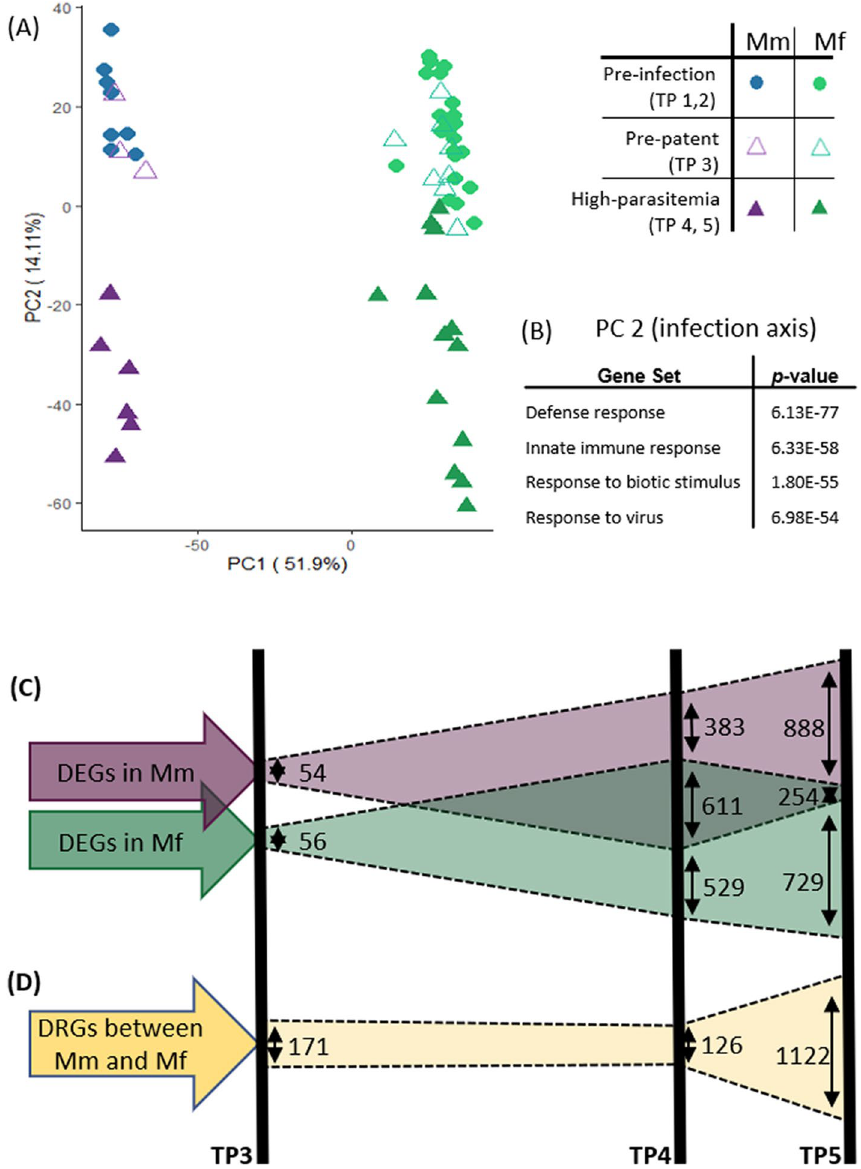
Figure 2. Transcriptomics patterns of whole-blood gene expression of all samples at time points TP1–TP5 from Mm and Mf. ( A ) Principal component analysis (PCA) of all samples from Mm and Mf. PC1 captures inter-species variance in expression profiles, while PC2 captures temporal variance in expression profiles. Pre-infection samples TP1 and TP2 (before infection) form species-specific clusters that are separate from the samples at TP4 and TP5, reflecting peaking parasitemia. TP3 (3 days after inoculation of sporozoites, and prior to blood-stage parasitemia, i.e ., the pre-patent period) samples cluster with the pre-infection samples TP1 and TP2. ( B ) Top GO gene sets over-represented in PC2. ( C ) Differentially expressed genes (DEGs) and ( D ) Differentially responding genes (DRGs) in TP3-TP5. The numbers of DEGs change significantly between TP3 (~ 50) and TP4 (~ 1000–1140) for both Mm (purple) and Mf (green), and then remain similar between TP4 and TP5 (~ 1000–1100) for each species. However, the number of common DEGs between Mm and Mf decreases substantially from TP4 (611) to TP5 (254). Concomitantly, the DRGs between TP4 and TP5 (gold) increase